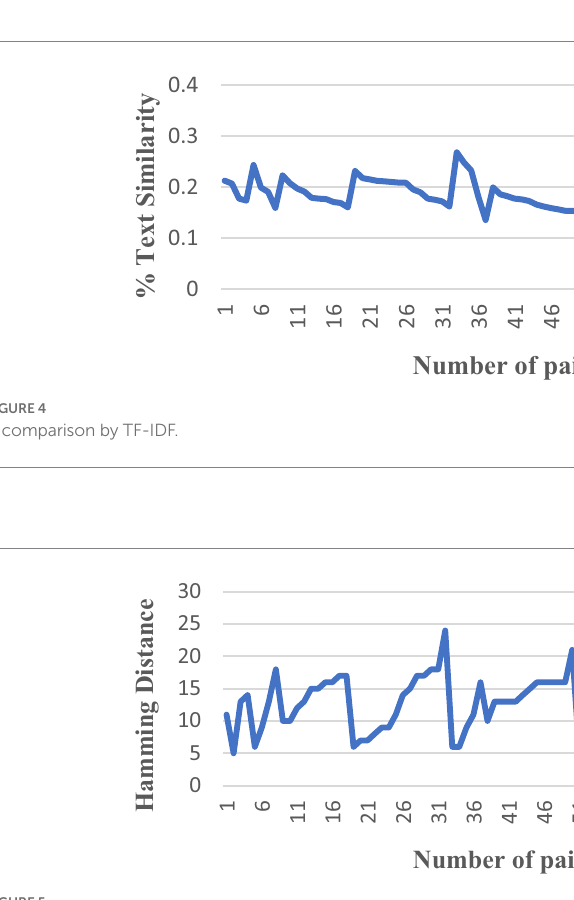
FIGURE 5 A comparison by